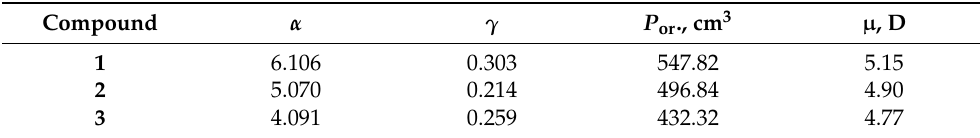
Table 1. Coefficients of calculated equations ( α , γ ), orientation polarizabilities ( P or .), and experimental dipole moments ( µ ) of compounds 1 – 3 in benzene. Compound α